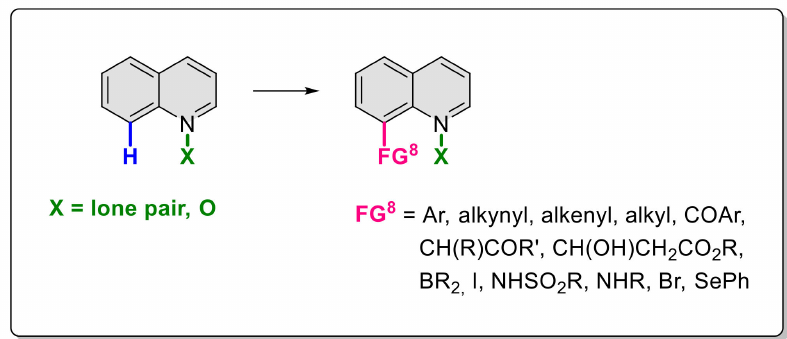
Scheme 62. Scope of the selective C-H functionalization achieved in position 8 to